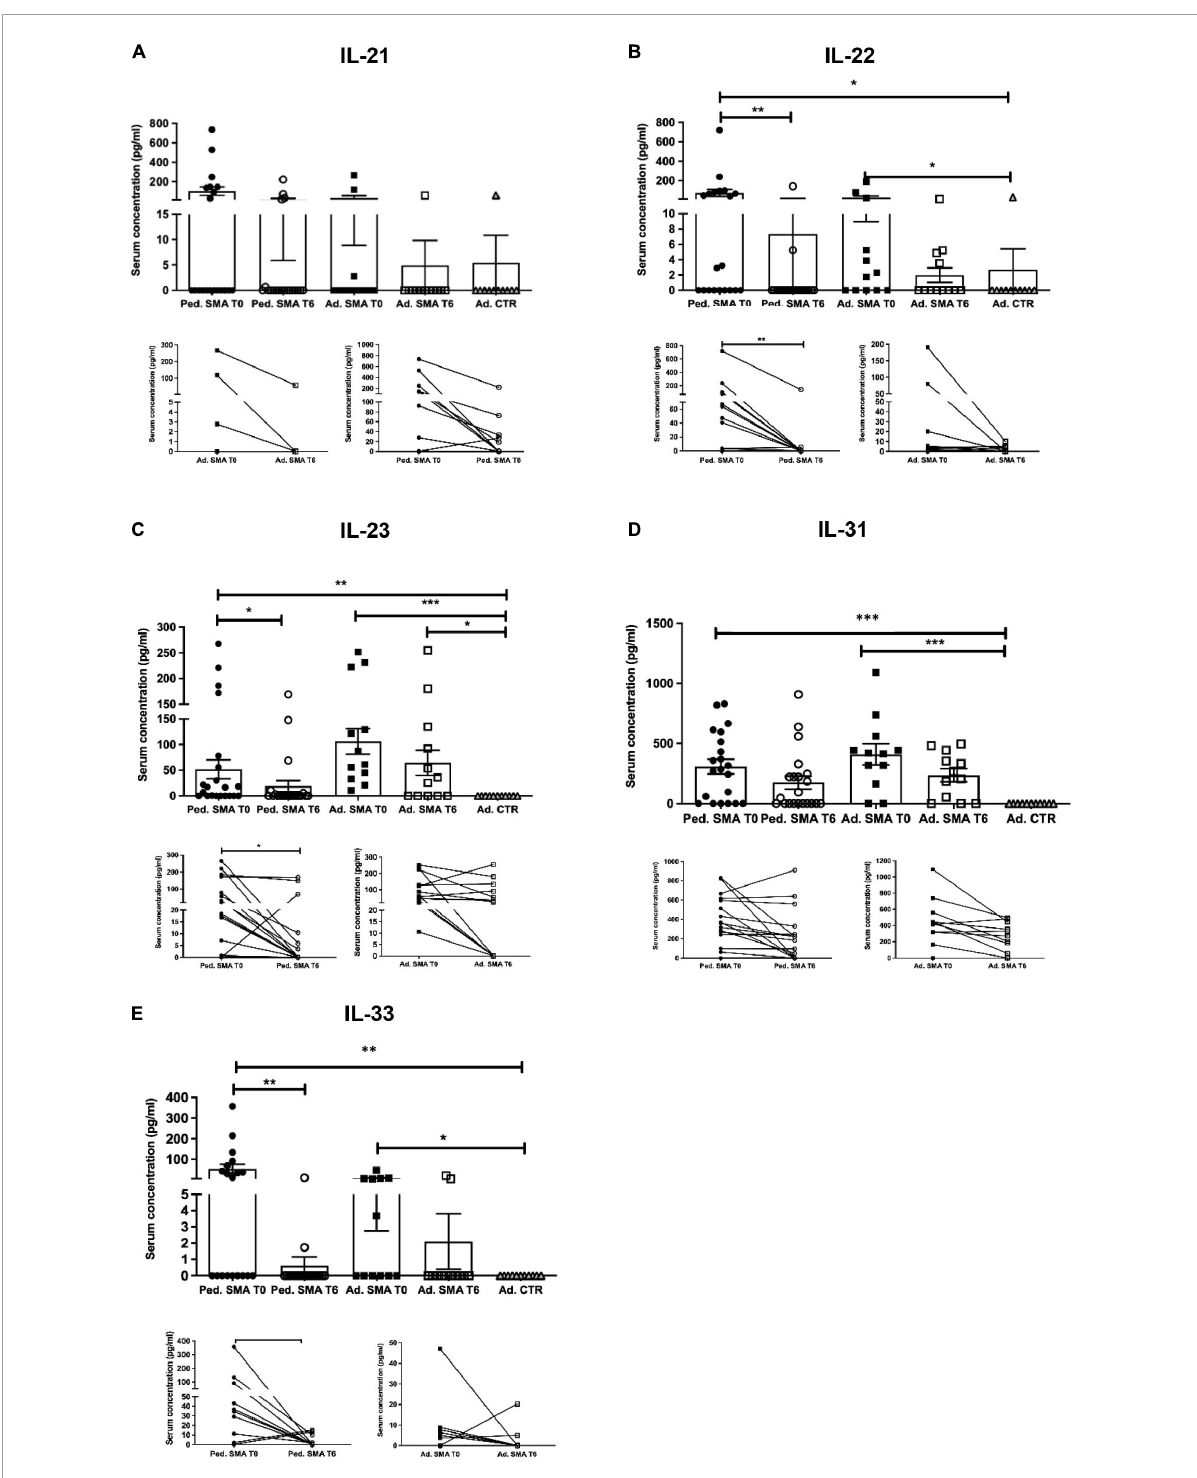
FIGURE3 Levels of cytokines in the serum of pediatric and adult spinal muscular atrophy (SMA) patients. The concentration (pg/ml) of (A) IL-21, (B) IL-22, (C) IL-23, (D) IL-31, and (E) IL-33 was measured in the serum of pediatric (Ped.; circle, N = 21) and adult (Ad.; square, N = 12) SMA patients at baseline (T0 black) and after 6 months of nusinersen treatment (T6 white), and in healthy controls (gray triangle) by multiplex immunoassay. Data in the graphs are reported as mean ± SEM for each sample group. The before-after graphs contains the mean cytokine concentration obtained for each patient in the duplicate multiplex immunoassays reactions before and after 6 months of nusinersen treatment (T0 and T6). * p < 0.05, ** p < 0.001, p < 0.0001*** by Mann–Whitney